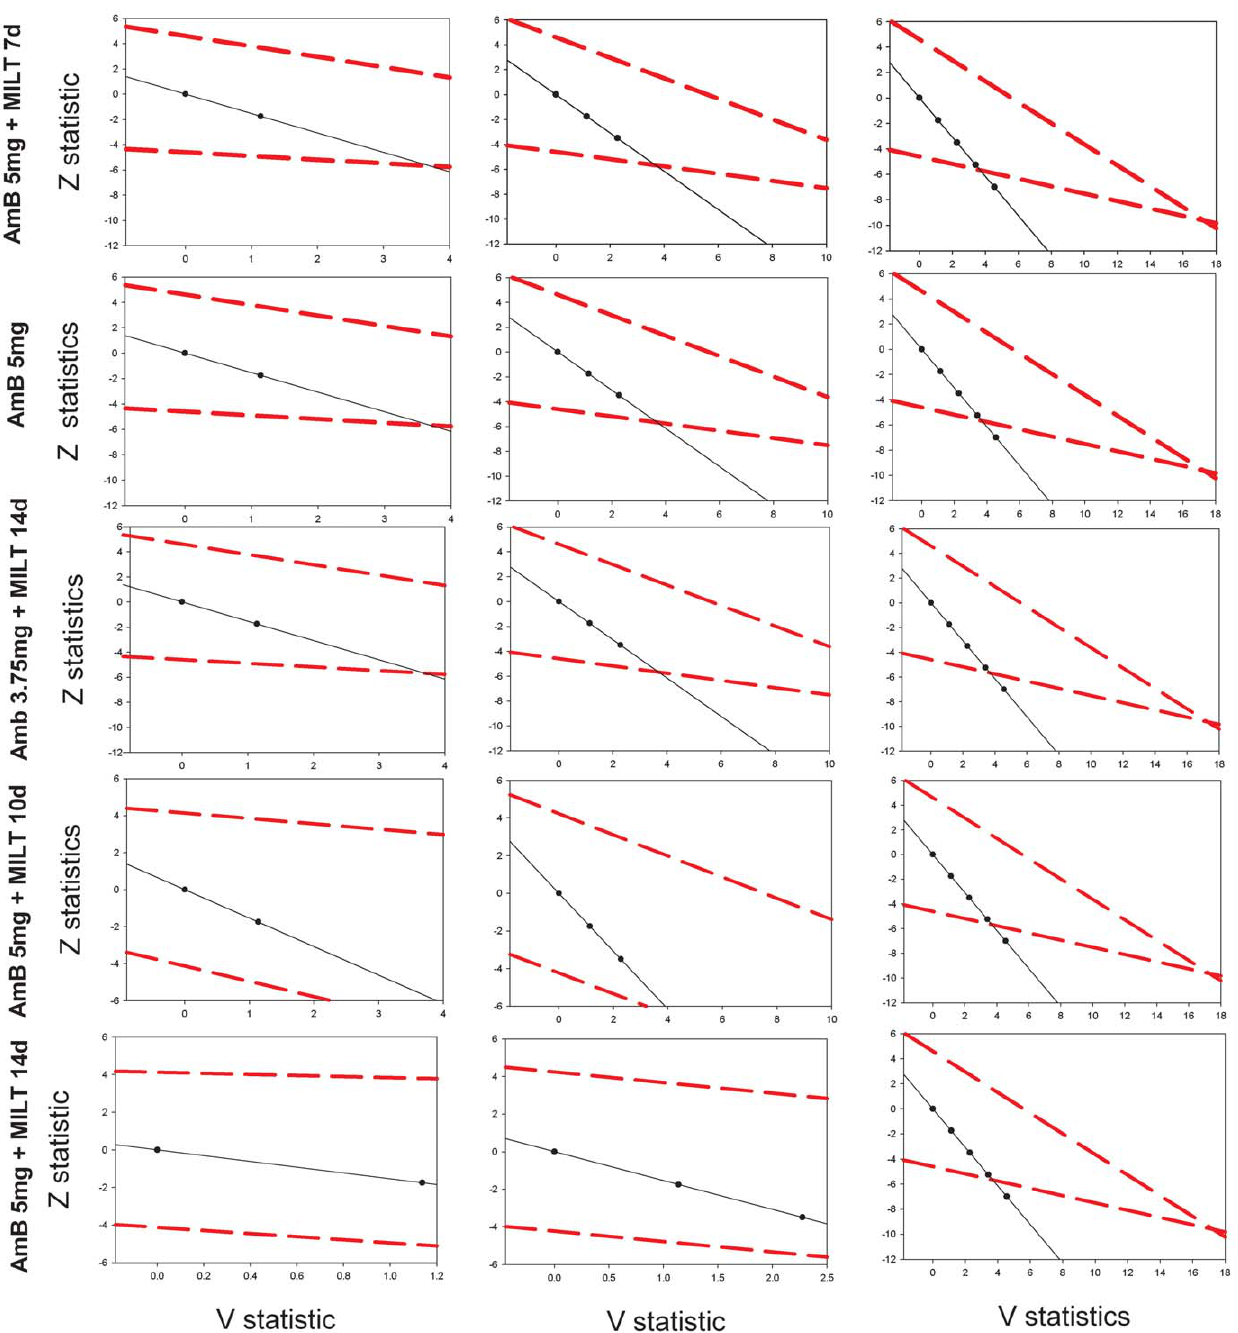
Figure 2. Patient enrolment in a Phase 2 study of visceral leishmaniasis with triangular design.